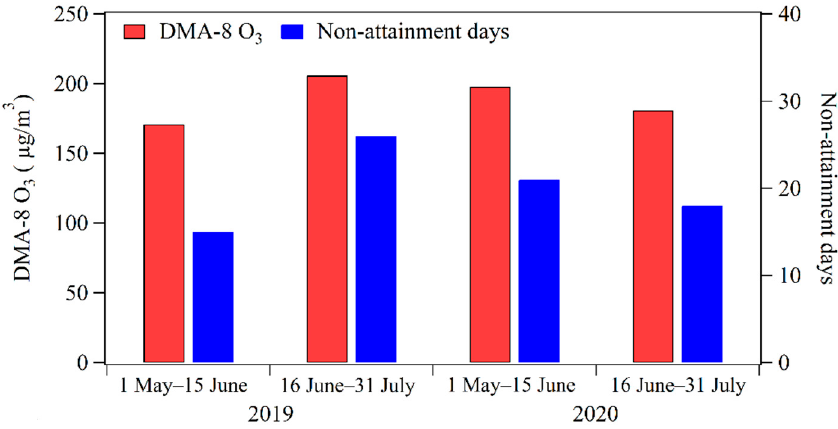
Figure 4. Comparison of DMA-8 h O 3 concentrations and O 3 non-attainment days during 1 May–